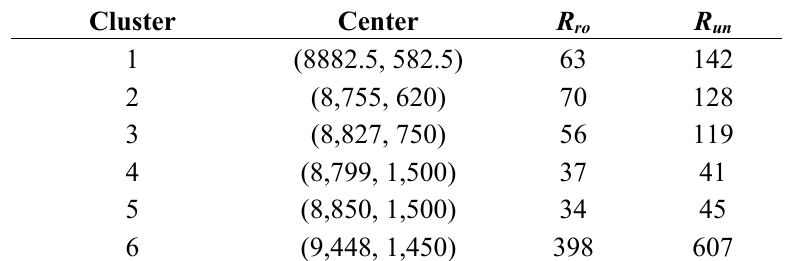
Table 4. Centers, rough boundary radiuses and uncertain boundary radiuses of